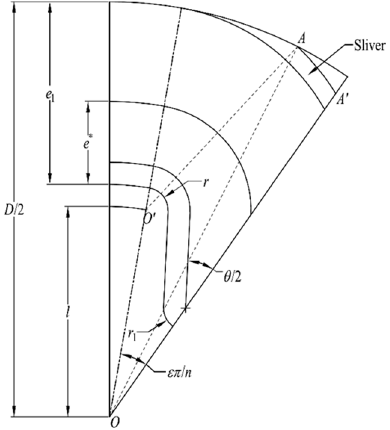
Figure 2. Schematic of the star-grain section.